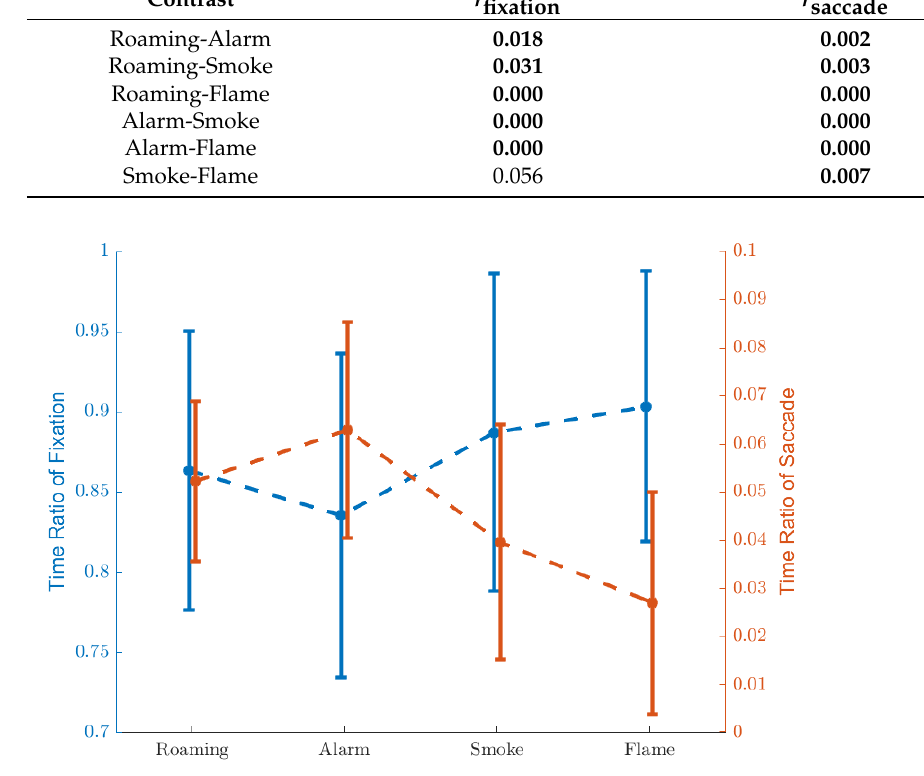
Figure 11. Time ratios of fixation and